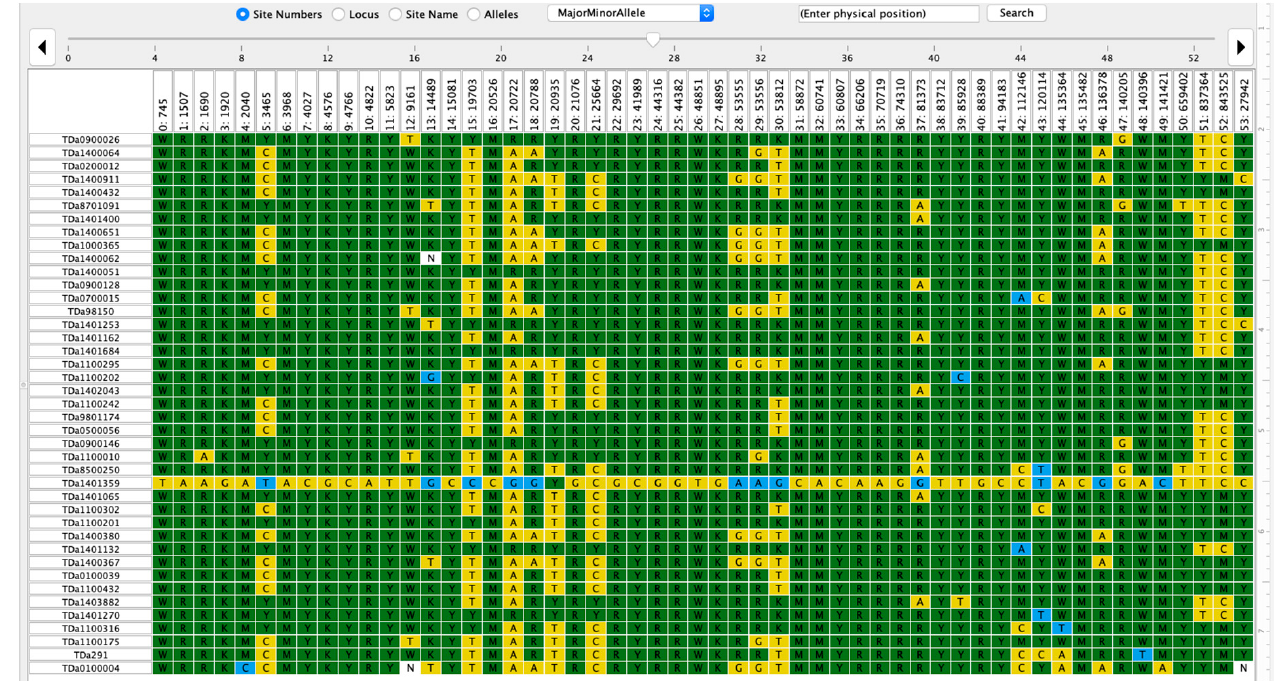
Figure 5. Male haplotype view for plant sex markers in D. alata. Yellow color refers to homozygosity while the dark green color indicates heterozygosity of the clone for the particular marker haplotype. The white color is associated with missing SNP markers information. TDa stands for Tropical D. alata and the number following TDa is a mention of the breeding code or accession number in the yam breeding program or the IITA Genetic Resource Center. The variable row represents the 54 sex markers identified by GWAS.